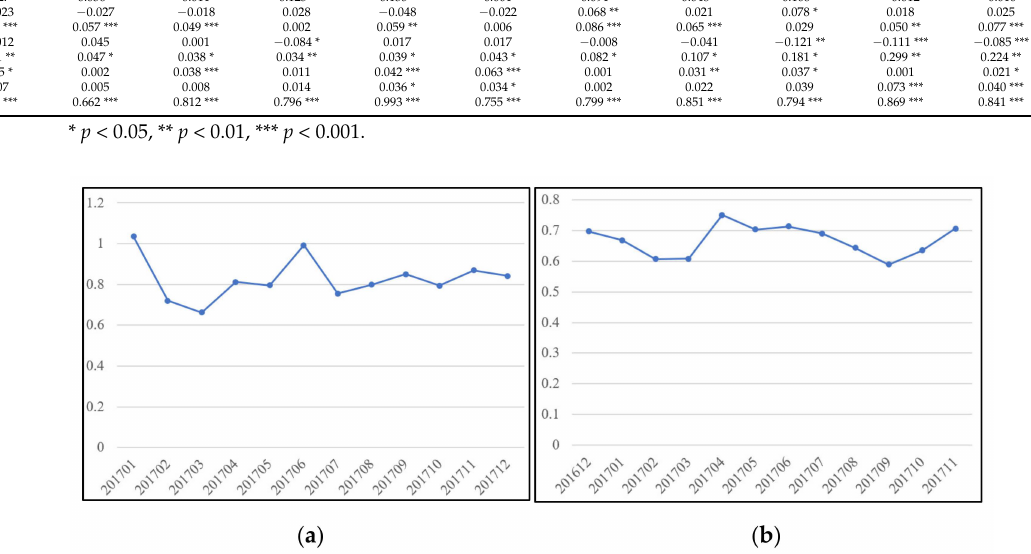
Figure 8. Temporal variations of ( a ) parameter estimate of stlag, ( b ) Moran’s I